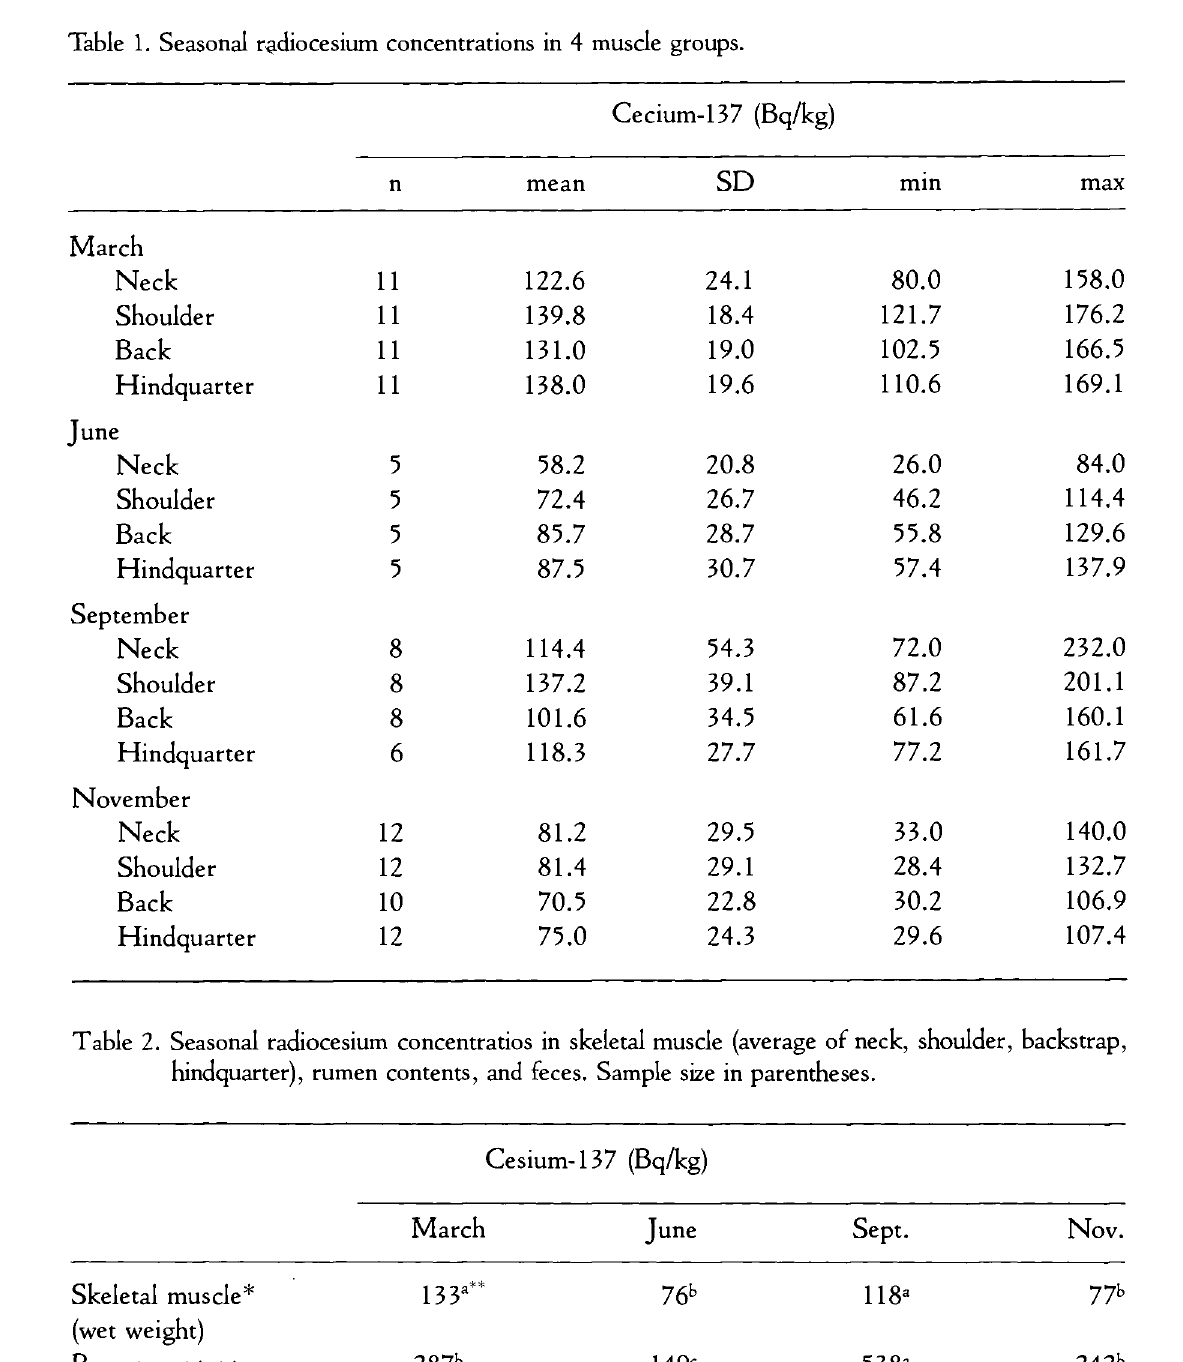
Table 1. Seasonal r.adiocesium concentrations in 4 muscle groups.